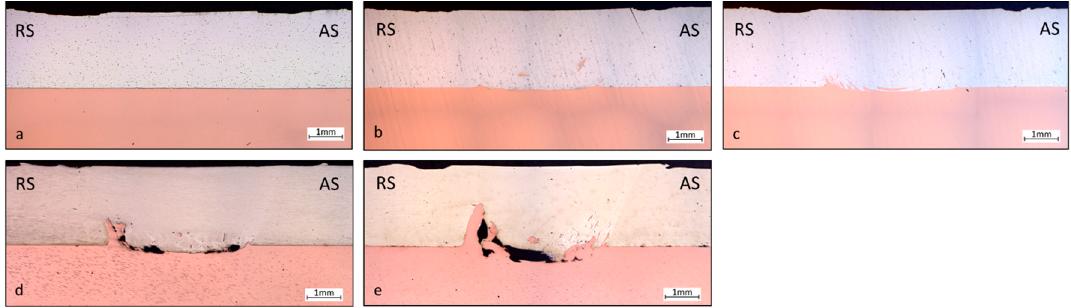
Figure 3. Influence of the pin length on the interface structure: ( a ) 1.8 mm; ( b ) 2.0 mm; ( c ) 2.2 mm; ( d ) 2.4 mm and ( e ) 2.6 mm. AS: Advancing Side, RS: Retreating Side.